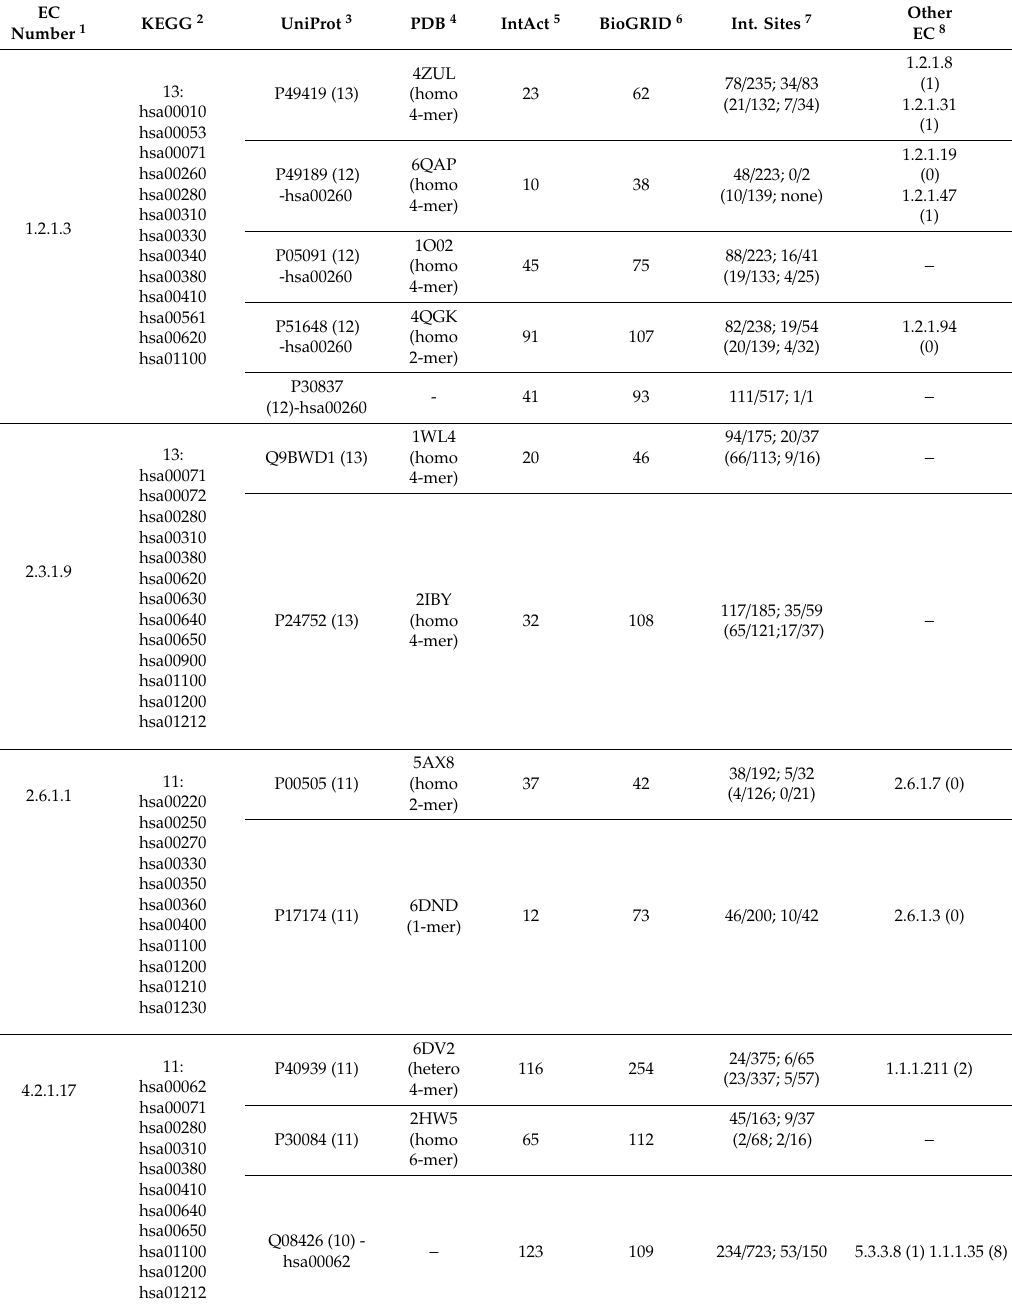
Hyphens in table cells refer to lack of information. 1 The list of functional activity names corresponding to EC numbers is available in Table S1A. 2 Number of metabolic KEGG associated to the EC number and list of corresponding IDs; the